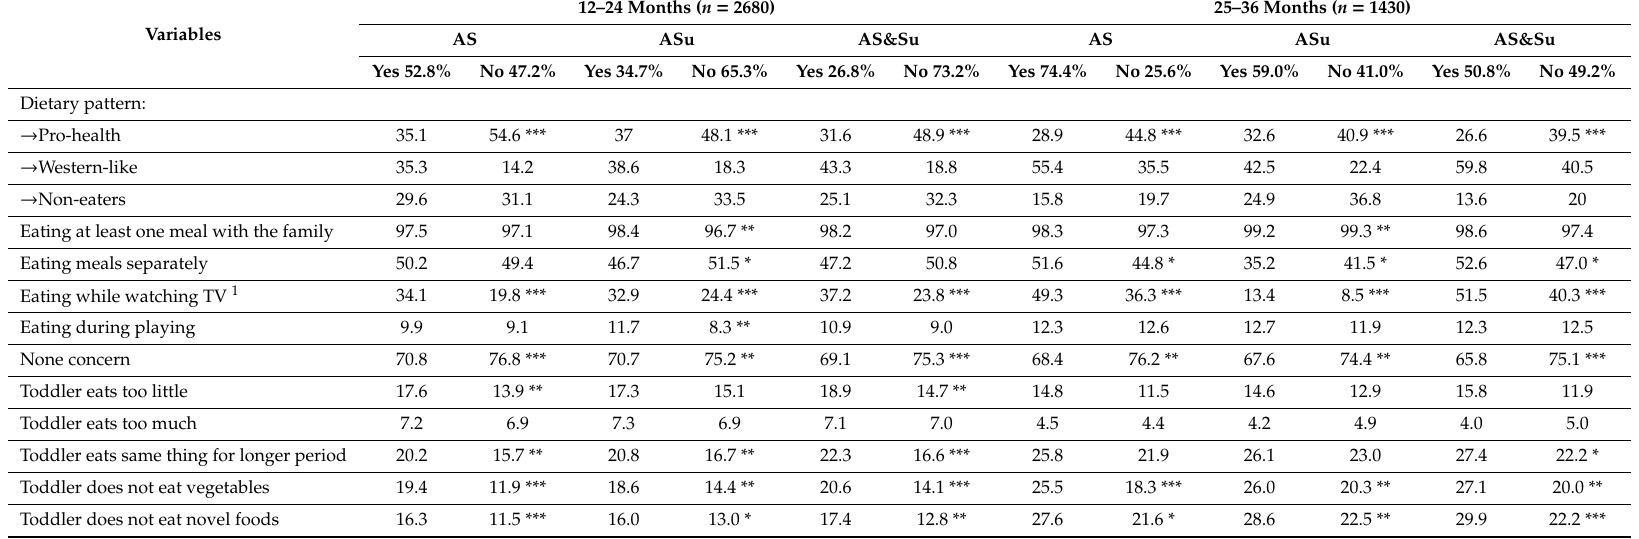
Table 4. Current toddlers’ dietary habits and maternal concerns about toddlers’ feeding according to the age group and use of added salt, sugar, and both salt and sugar in the Polish sample ( n =